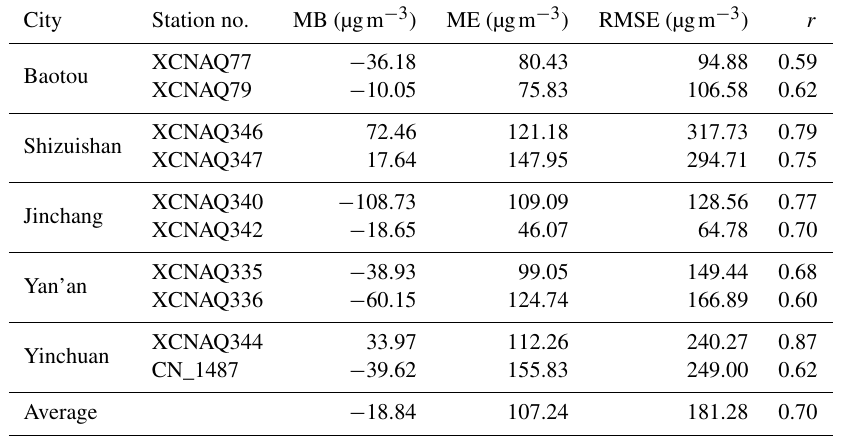
Table 1. Performance statistics for the model in simulating surface PM 10 concentrations at environmental monitoring stations during the simulation period.